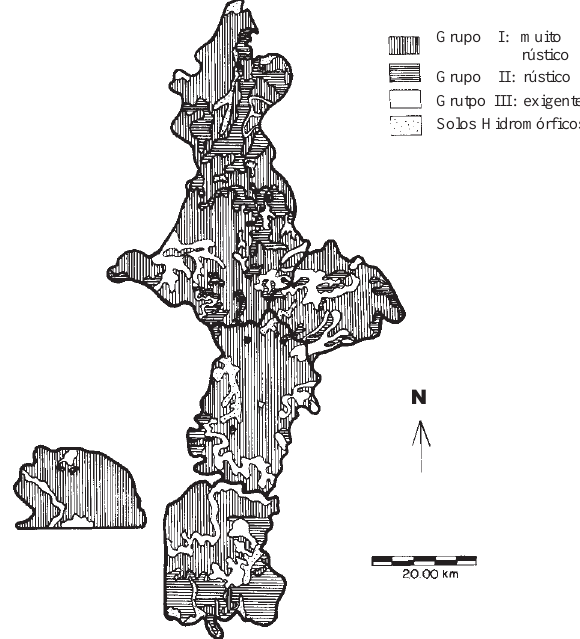
Figura 3. Zonas de cultivo dos grupos de espécies selecionadas para adubação verde na Zona Agroecoadministrativa de São